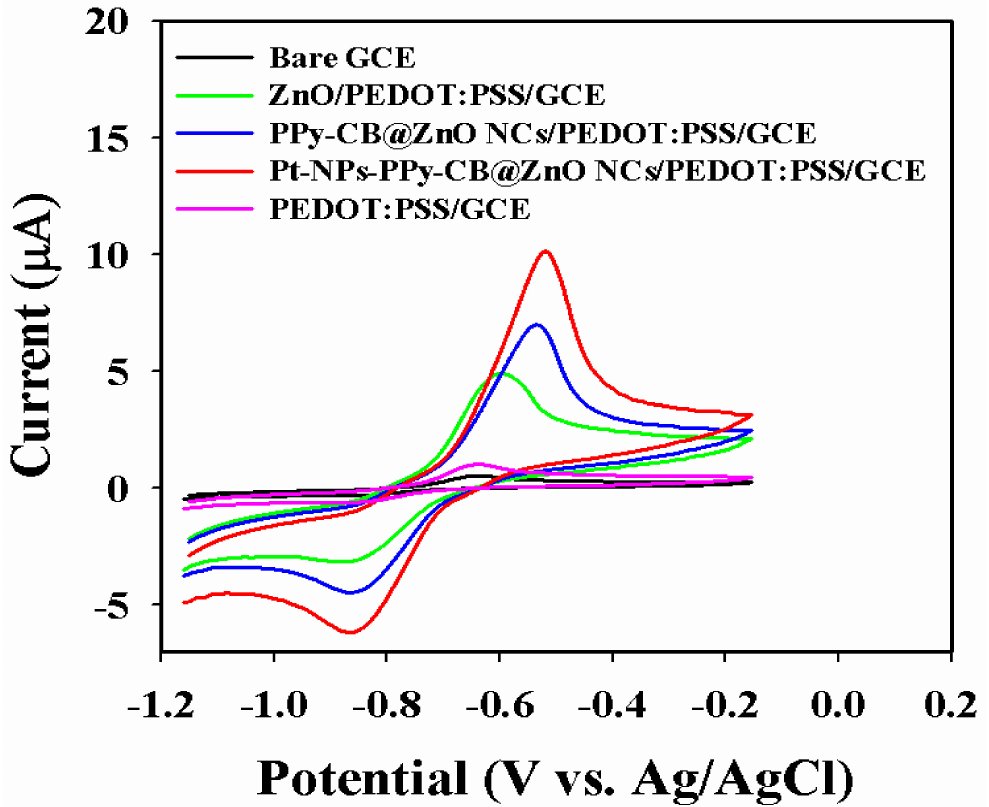
Figure 8. Control experiment executed at 16.5 µ M of 4 − NP using modifired GCE with